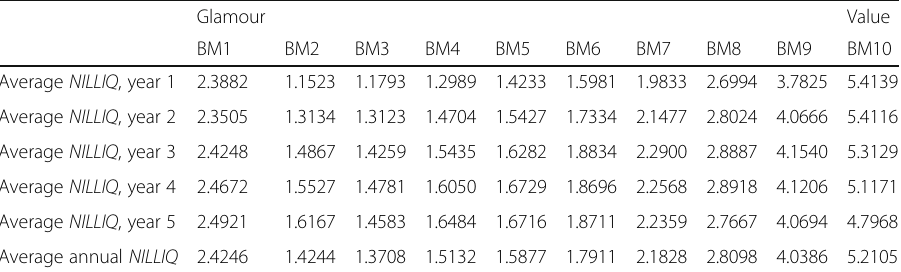
Table 2 Average normalized illiquidity, book-to-market portfolios. Ten portfolios are formed using book-to-market data at the end of April for each year in the 33-year period between 1968 through 2000 for all AMEX and NYSE stocks identified on CRSP, following the methodology detailed in Lakonishok et al. (1994). For each year for each stock in each portfolio, Amihud (2002) ‘ s illiquidity measure is estimated for each stock for which 100 trading observations are identified,